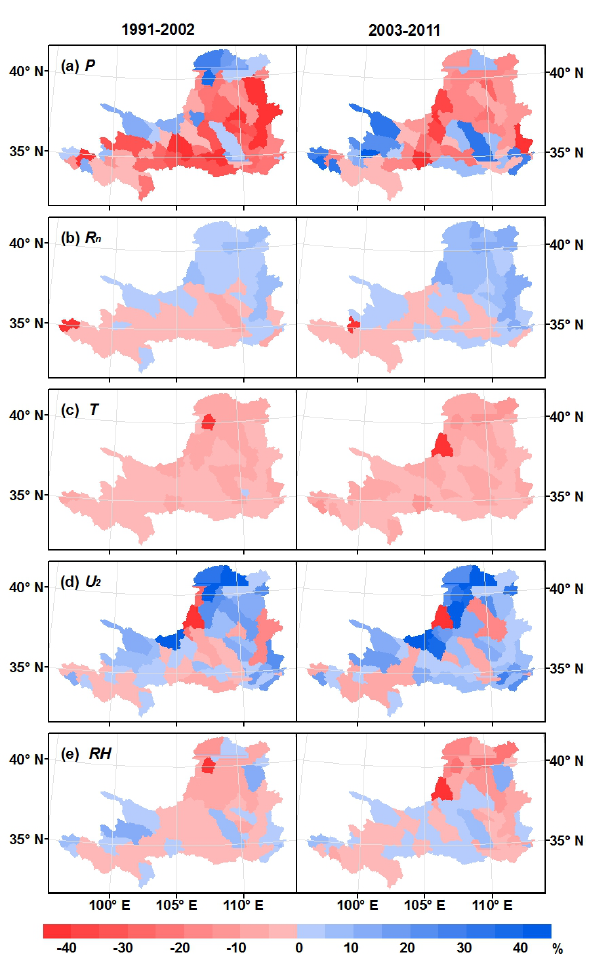
Fig. 5. The contributions of the changes in precipitation: (a) net radiation, (b) air temperature, (c) wind speed, (d) and relative hu- midity (e) to the runoff changes in the low-flow (left) and recent (right) periods at the